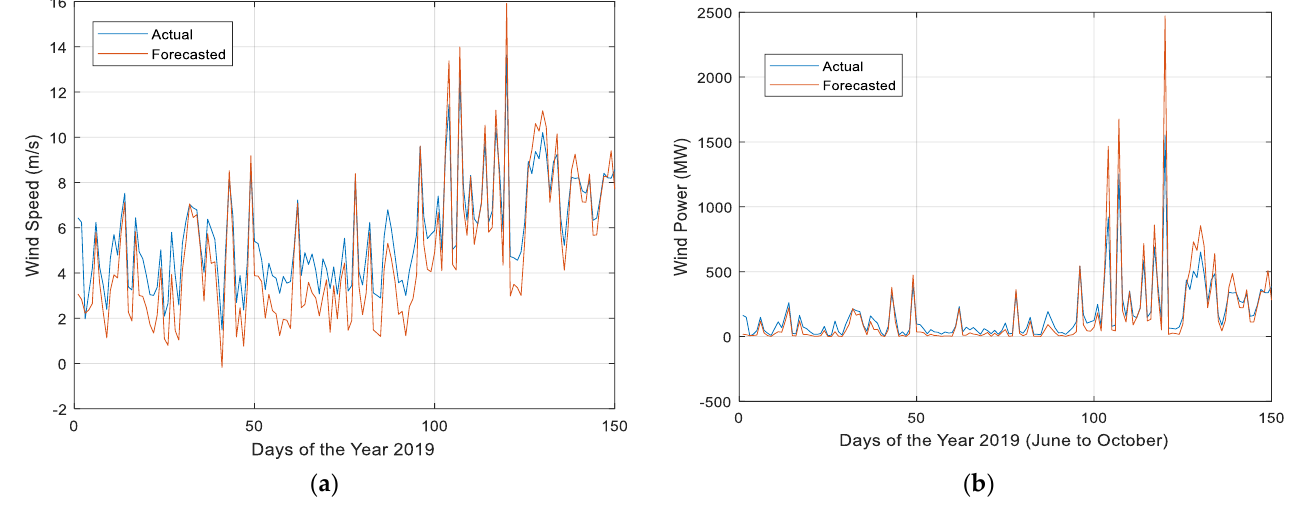
Figure 13. ( a ) Comparative analysis of wind speed forecasting by the CFNN trained through HPSOBA. ( b ) Comparative analysis of wind power forecasting by the CFNN trained through HPSOBA.